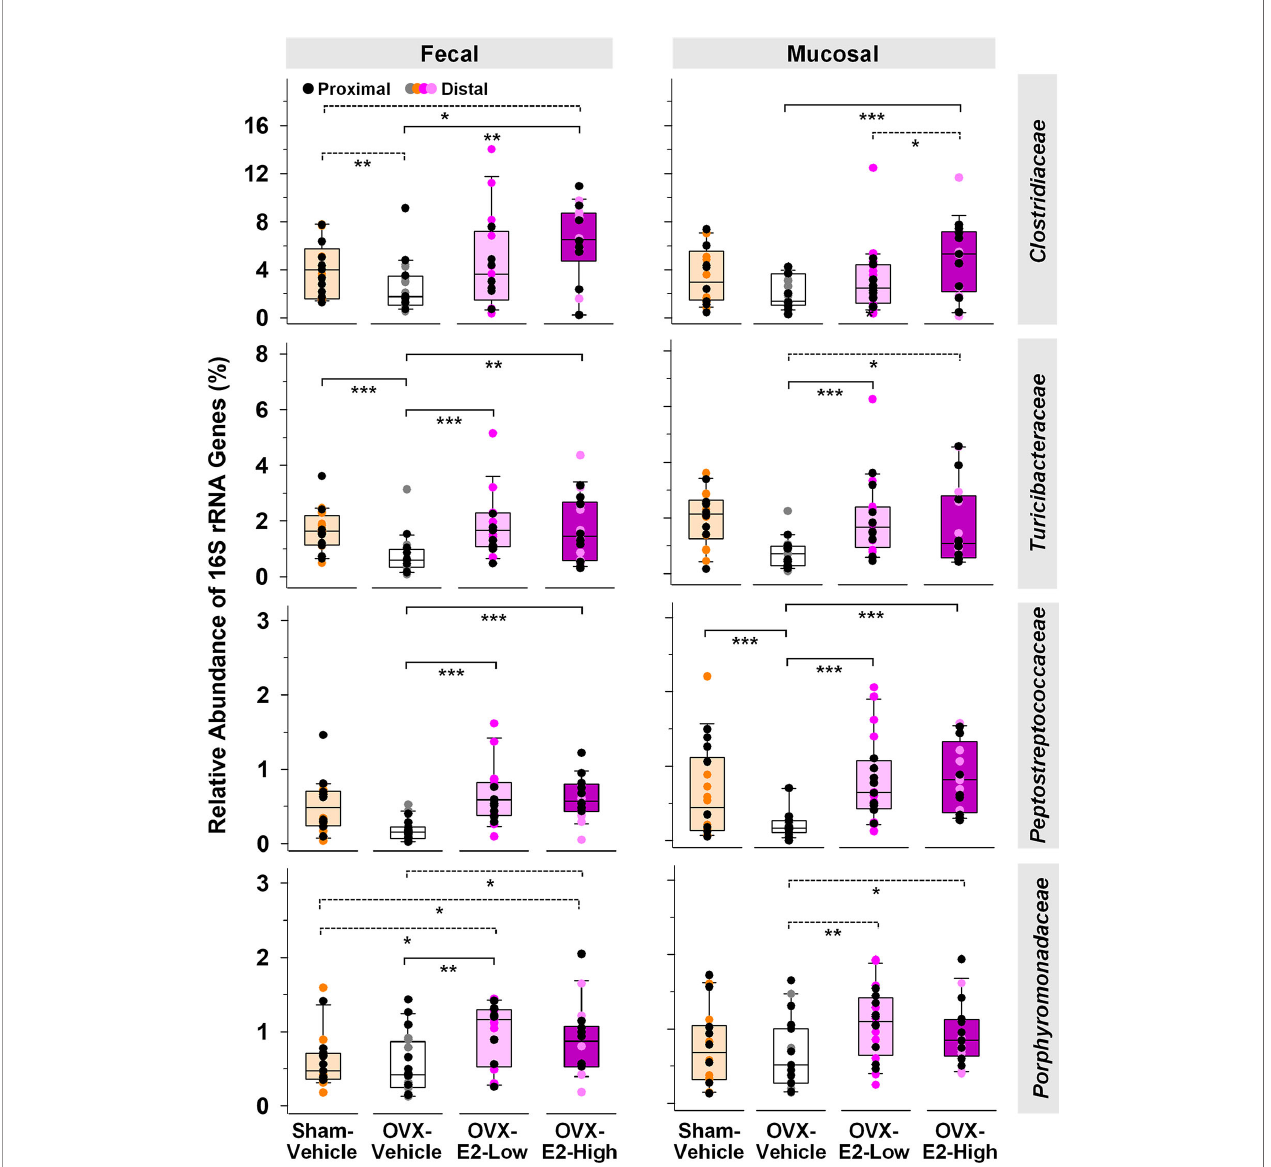
FIGURE 1 | Microbial gut phylotypes at the family level that displayed signi fi cantly higher (Linear discriminant analysis effect size [LEfSe]) relative abundances in OVX- E2-High rats than in OVX-Vehicle rats. Statistical analysis was limited to families that had a ≥ 2% relative abundance in at least one sample. The asterisks indicate signi fi cant differences (*p ≤ 0.05; **p ≤ 0.01; ***p ≤ 0.001). Solid lines between groups indicate signi fi cant q values. Dashed lines between groups indicate non- signi fi cant q values (q ≥ 0.05). Group abbreviations (e.g., Sham-Vehicle) are described in Table 1 . Error bars indicate standard